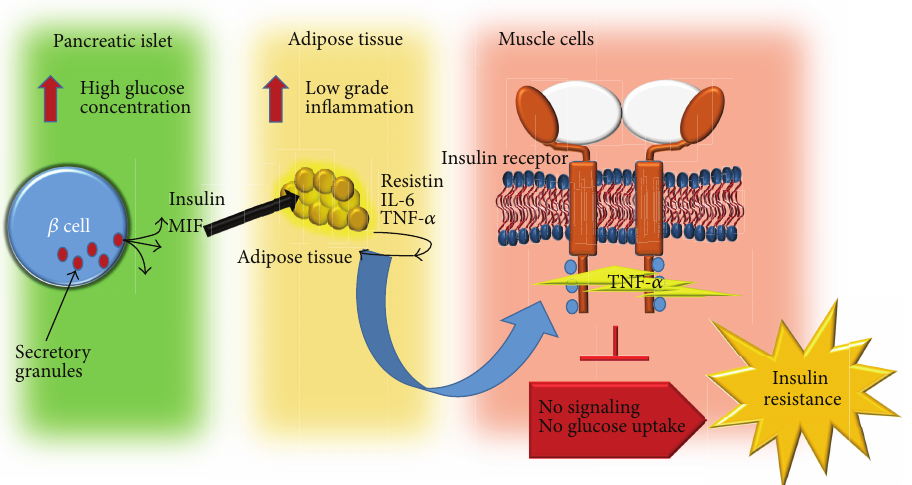
Figure 3: MIF plays an indirect role in T2DM development by promoting the production of proinflammatory cytokines and adipocytokines that are involved in insulin receptor signaling, leading to insulin